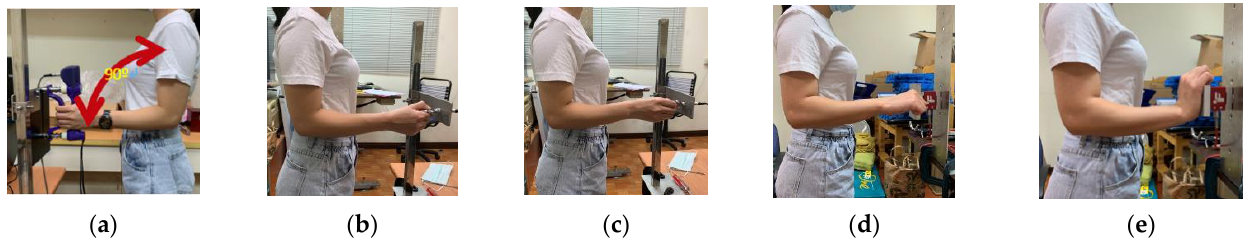
Figure 1. Five types of hand strength measured in this study: ( a ) power grip; ( b ) lateral pinch; ( c ) palmar pinch; ( d ) thumb press; and ( e ) ball of thumb press.